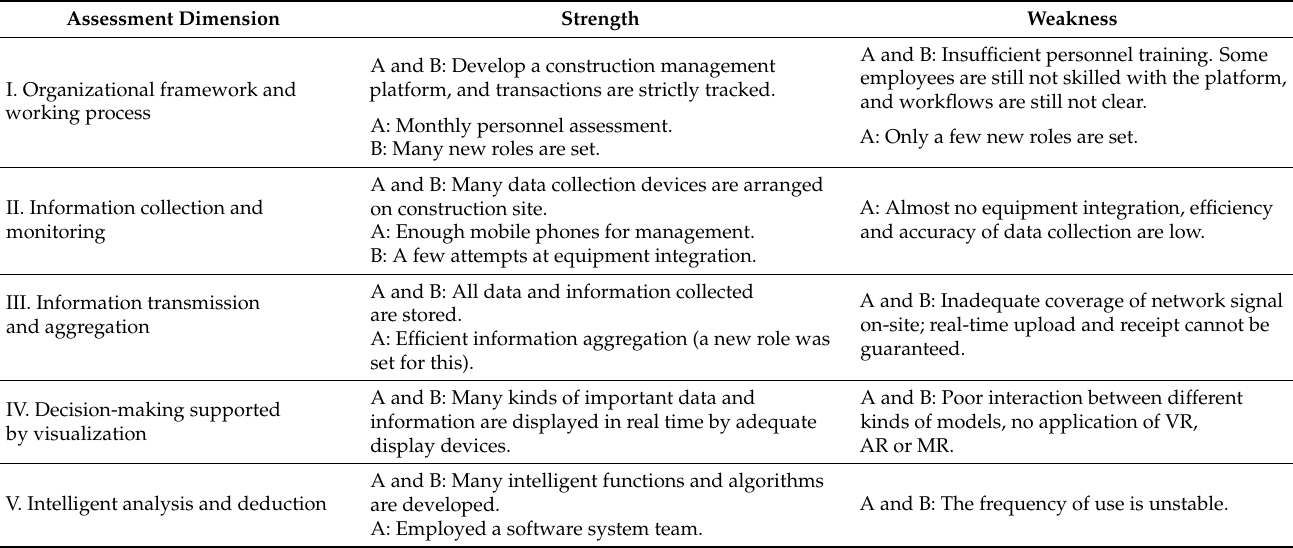
Figure 5. The radar chart of enterprises A and B. Table 9. Detailed situations of the ICM maturities of enterprises A and